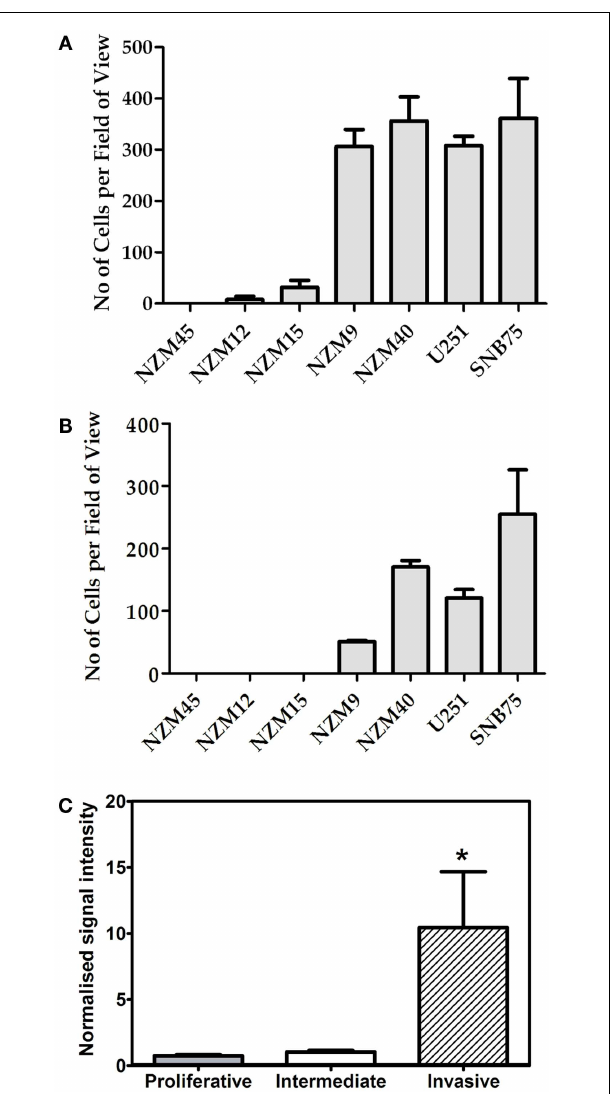
FIGURE 1 | GLIPR1 expression and promoter methylation in melanoma cells . (A) Relative mRNA transcript levels of GLIPR1 in different melanoma and glioma cells were quantified by RT-qPCR, normalized to reference genesYWHAZ and UBC, and reported relative to levels in NZM15. Results are mean of three independent experiments and error bars indicate SEM. (B) GLIPR1 protein levels in different melanoma and glioma cell lines were determined by western blotting with each lane loaded with 100 µ g of total protein; the top GLIPR1 blot and β -tubulin loading control (bottom) was exposed for 5min, and the center GLIPR1 blot exposed overnight.Two separate experiments gave similar results. (C) Summary of bisulfite sequencing data showing GLIPR1 CpG promoter methylation status for melanoma cell lines with known invasive potential (this study). NZM09 and NZM40 are strongly invasive compared to the remaining cell lines. Lollipops represent individual CpG dinucleotides within a CpG island in the GLIPR1 promoter. DNA from three different vials of each NZM cell line was sequenced at least twice on both strands.White, unmethylated; black, methylated; black/white, hemimethylated.